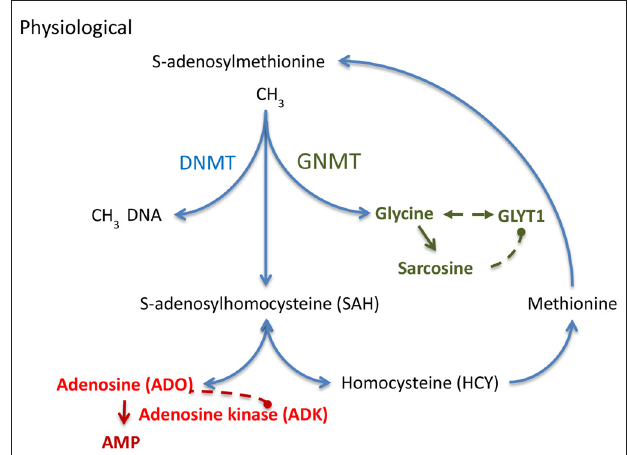
FIGURE 2 | S-adenosylmethionine (SAM) dependent transmethylation pathway, which is under the control of adenosine and glycine. Adenosine and glycine are regulated by adenosine kinase (ADK) and glycine transporter 1 (GlyT1), respectively. DNMT, DNA methyltransferase; GNMT, glycine